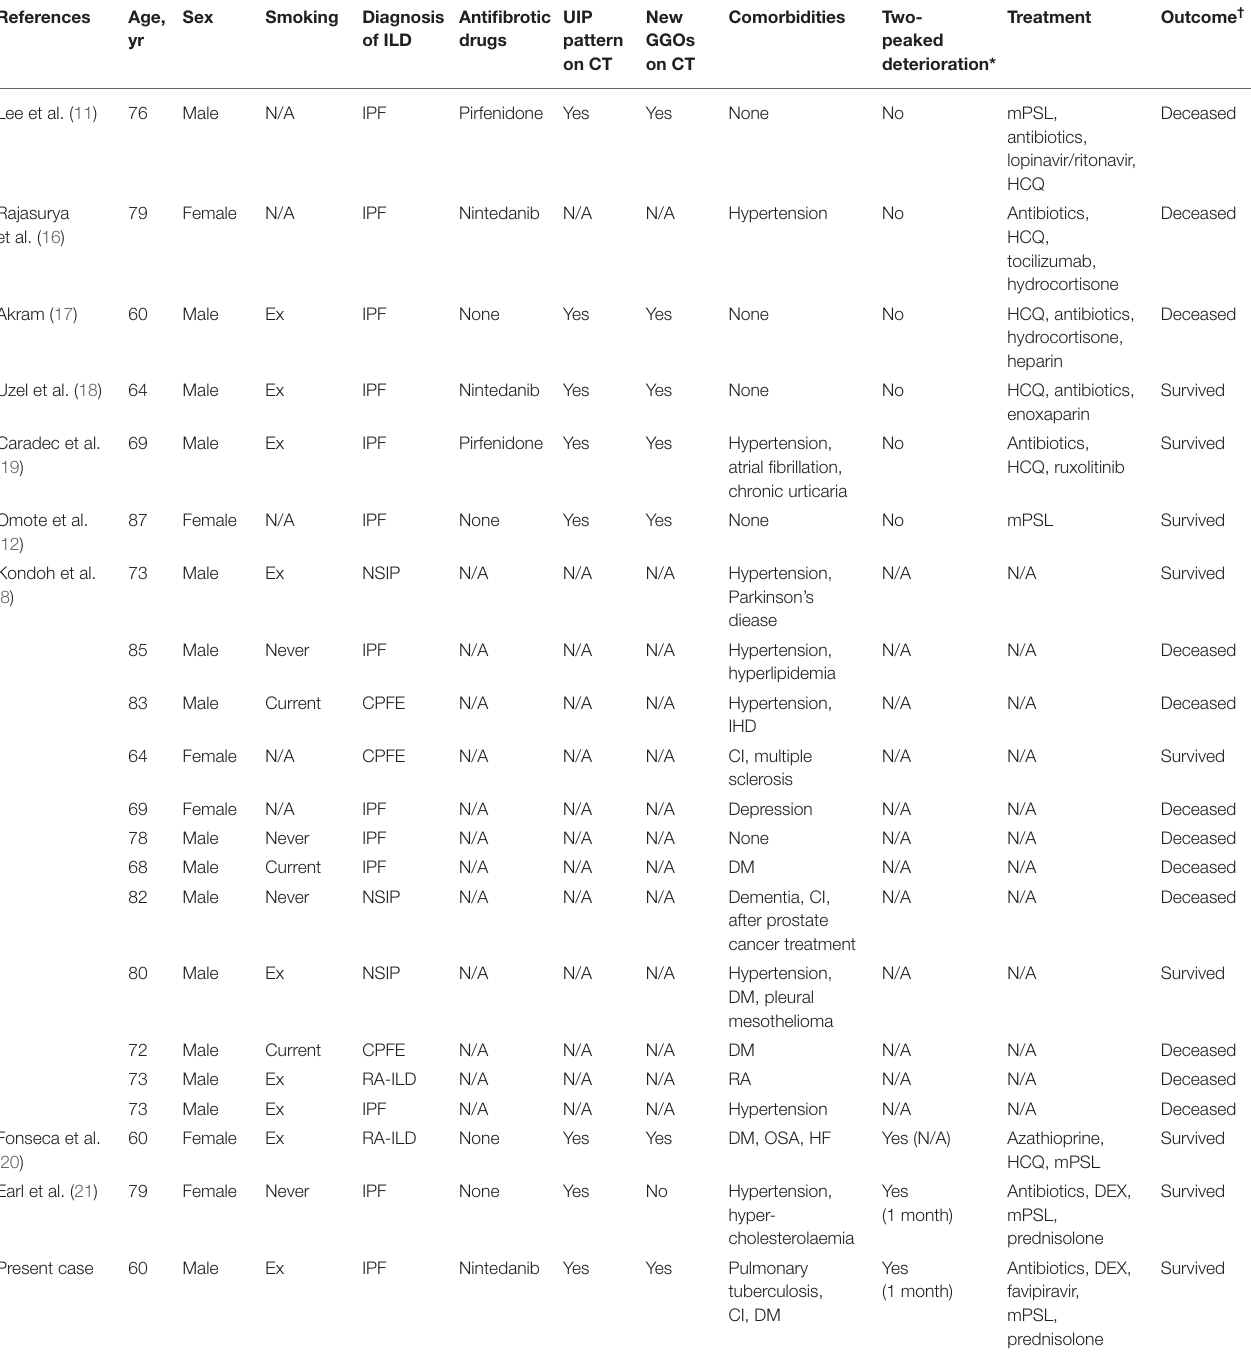
TABLE 2 | Summary of reported cases with chronic ILDs who developed respiratory deterioration by complications with